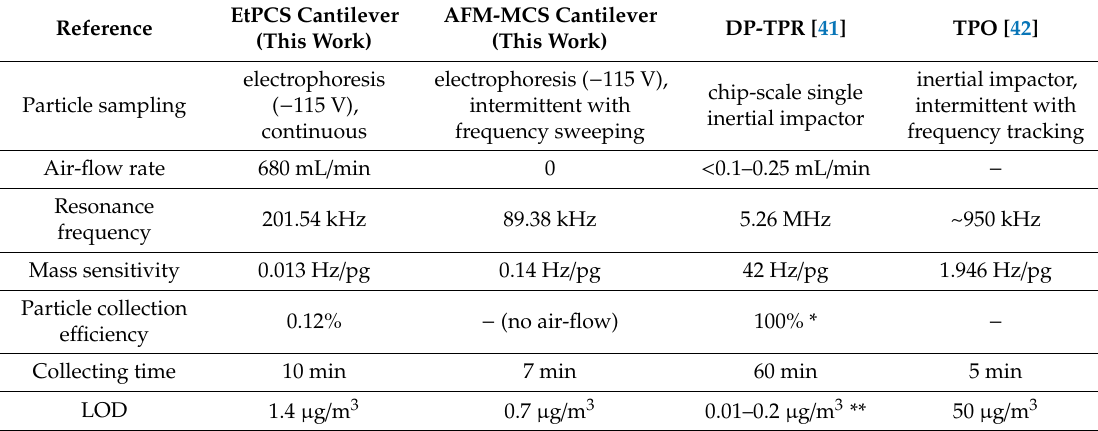
Table 1. Comparison of di ff erent piezoresistive gravimetric sensor